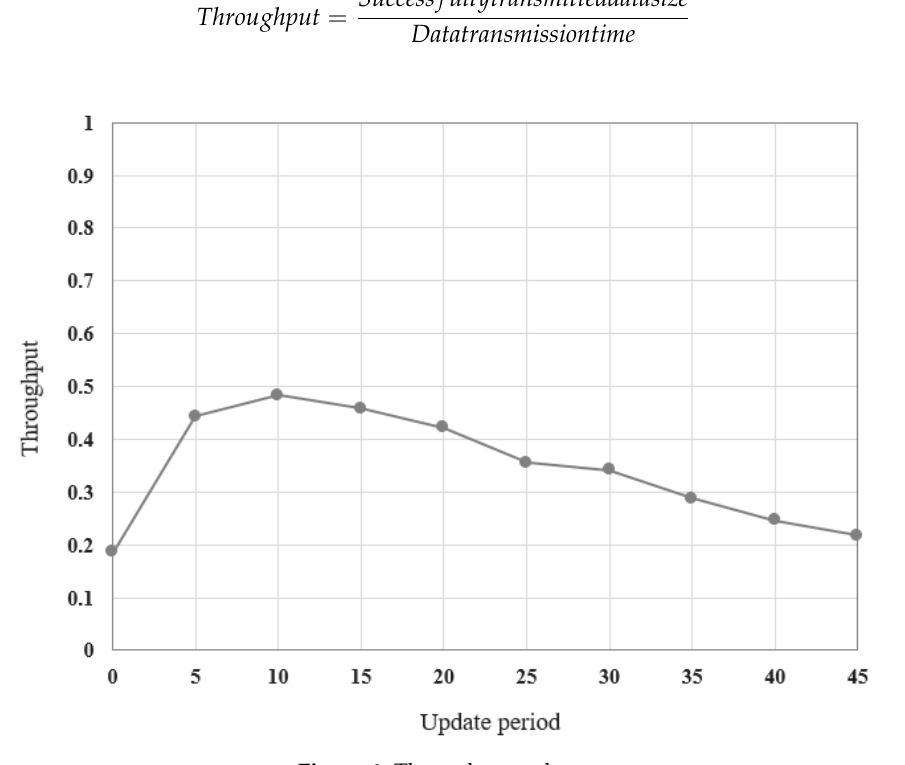
Figure 6. Throughput values.